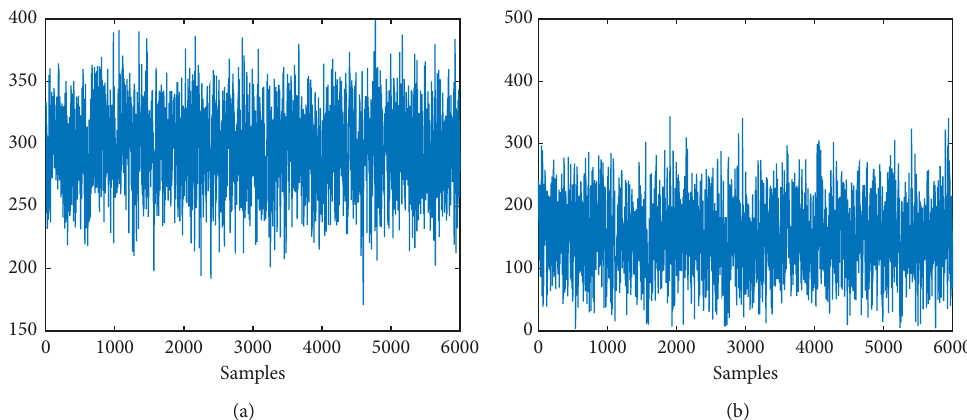
Figure 5: MCMC chain samples at DH1A1 for prior covariance matrix λ